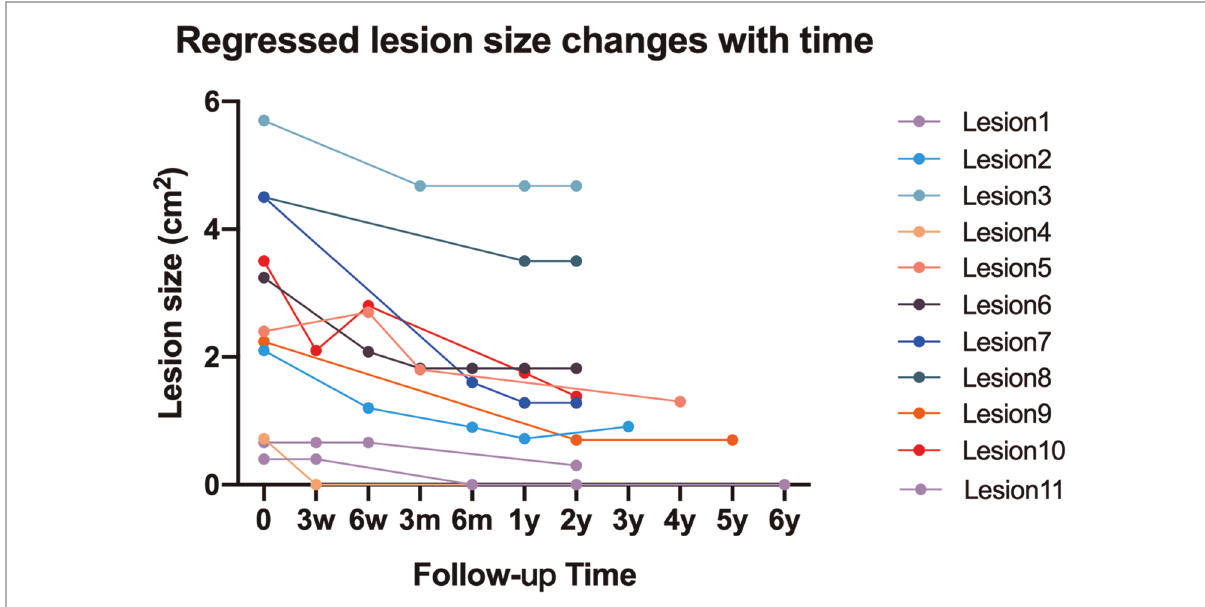
FIGURE 4 Line chart to show time-dependent change of lesion size in 11 regressed osteolytic